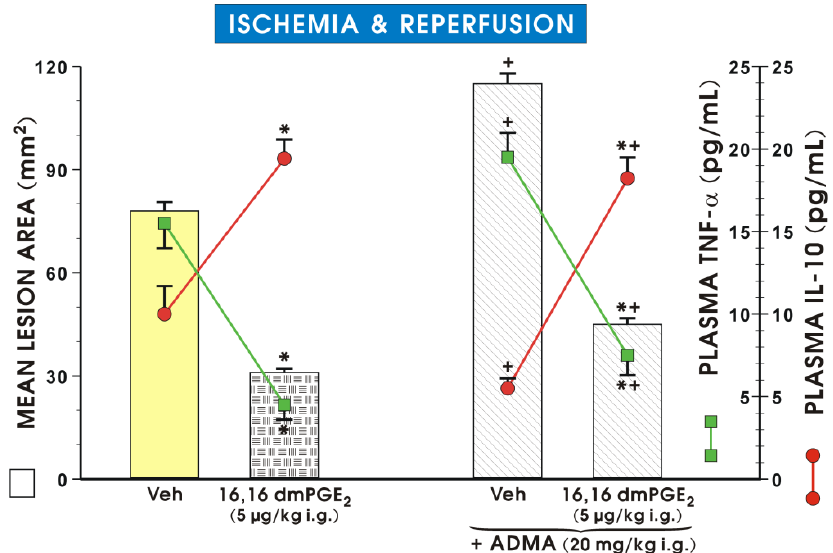
Figure 6. Mean lesion area, the alterations in GBF, and the plasma concentrations of proinflammatory cytokine TNF-α and anti-inflammatory cytokine IL-10 in rats pretreated with ADMA alone or ADMA applied in combination with synthetic prostaglandin E derivative, 16,16 dmPGE , and exposed 30 min later to gastric ischemia/reperfusion. 2 2 Results are mean ± S.E.M of 8 rats per group. Significant change ( p < 0.05) as compared with the respective values in the vehicle (saline)-control group, is indicated by an asterisk. A cross indicates the significant difference ( p < 0.05) between the values obtained in vehicle-controls with and without ADMA administration. An asterisk and a cross indicate significant change ( p < 0.05) as compared with the vehicle group in the presence of